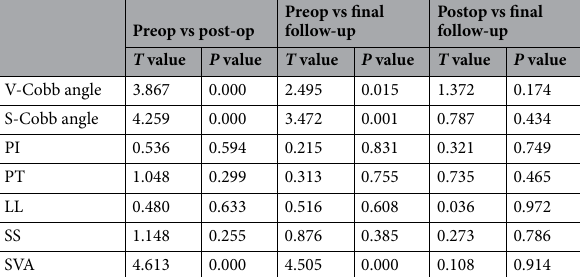
Table 4. Comparison of radiographic results at different time points. PI pelvic incidence, LL lumbar lordosis, PT pelvic tilt, SS sacral slope, Preop preoperative, postop postoperative, SVA sagittal vertical